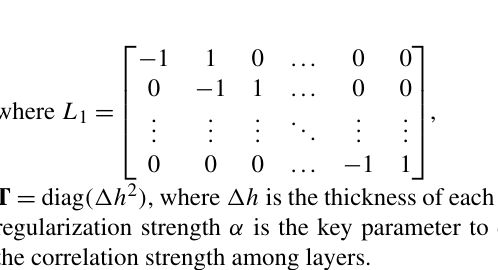
Figure 1. The transmittances of the species and solar lines in three bands from a typical spectrum at St Denis, together with the residual (observation–fitting). The transmittance of each component is shifted by 0.02 to better identify different species and the solar lines (sol).